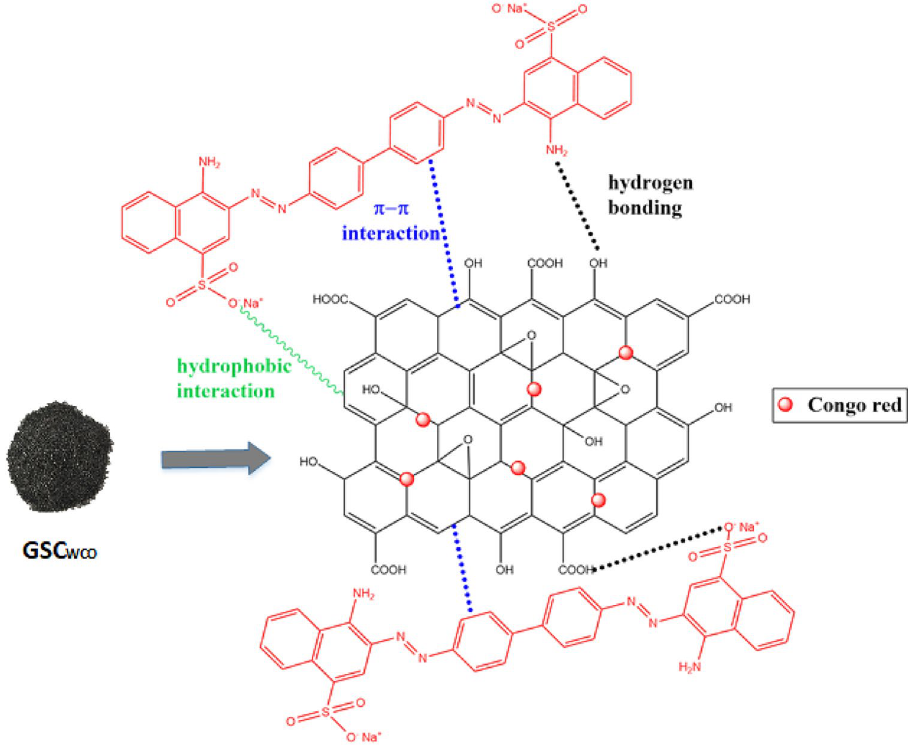
Figure 16. A proposed mechanism for the adsorption of CR on GSC WCO